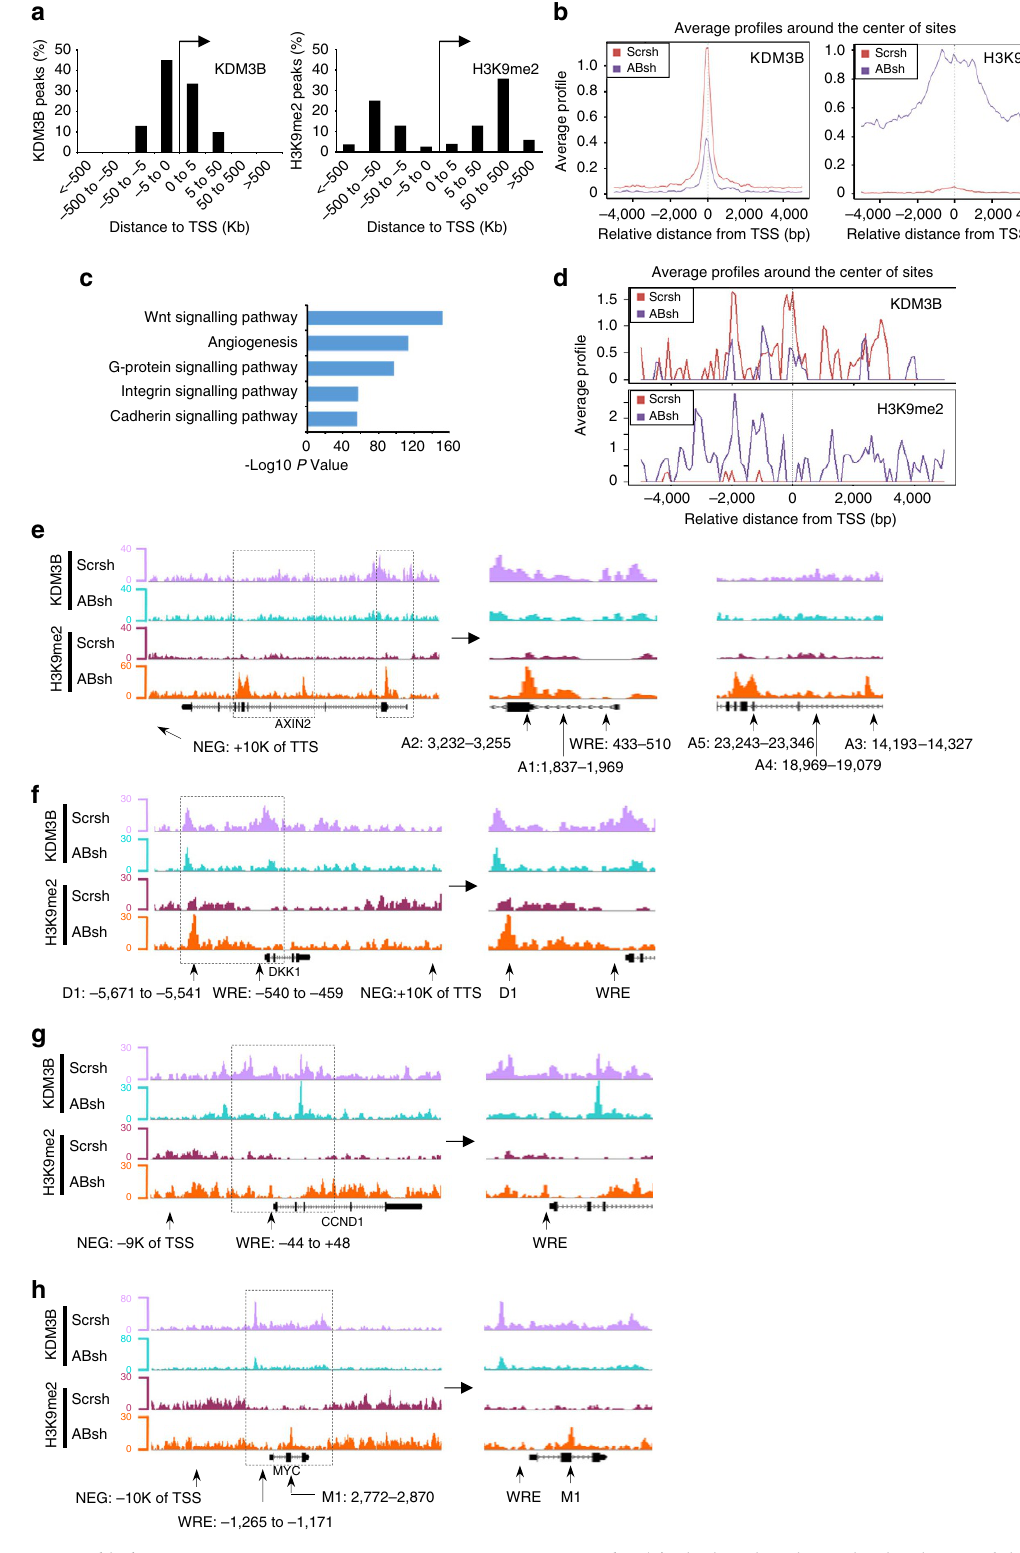
Figure 6 | KDM3A/B bind to Wnt target gene promoters to erase H3K9me2 marks. ( a ) The bar chat shows the distribution of distances between KDM3B or H3K9me2 peaks and TSS. ( b ) Average levels of KDM3B and H3K9me2 enrichment within ± 5kb of TSS in HCT116/ABsh-1 cells were compared to HCT116/Scrsh cells. ( c ) Gene ontology analysis of enriched H3K9me2 target genes. The x -axis value is (cid:2) log 10 of binomial raw P value. ( d ) Average levels of KDM3B and H3K9me2 around the Wnt target genes transcription start site in HCT116/Scrsh cells were compared to HCT116/ABsh-1 cells. ( e – h ) Representative view of ChIP-seq results in AXIN2, DKK1, CCND1 and MYC gene by Genome